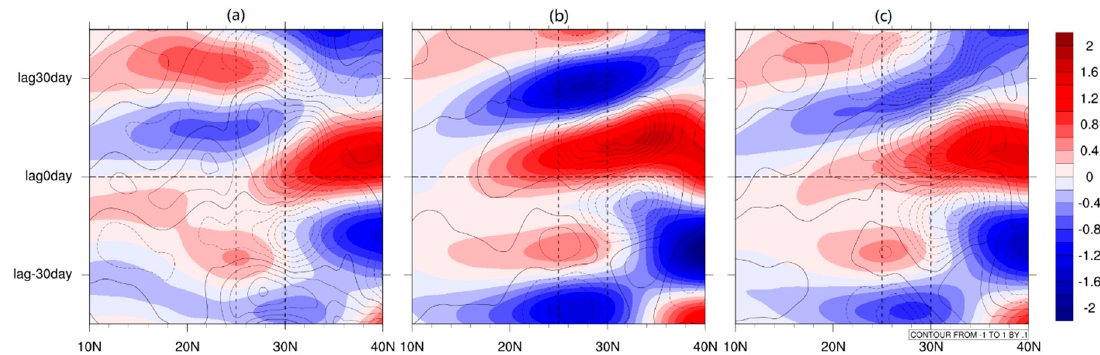
Figure 6. Same as Figure 5, but for 30-to-90-day intra-seasonal variability with doubled time scales for the ordinate. EHW events persisting less than 15 days ( a ), longer than 15 days ( b ) and ( c ) all EHW